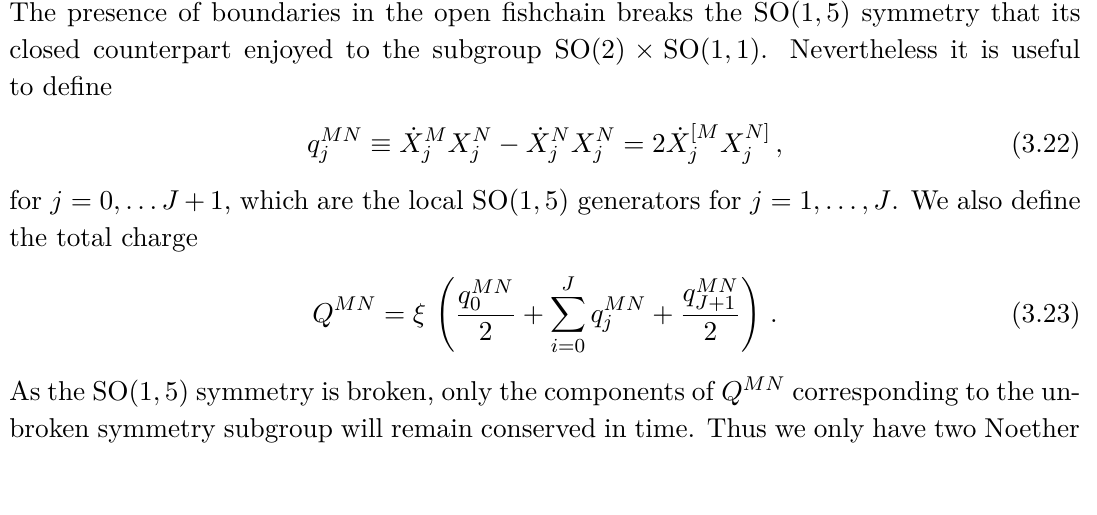
JHEP07(2021)127